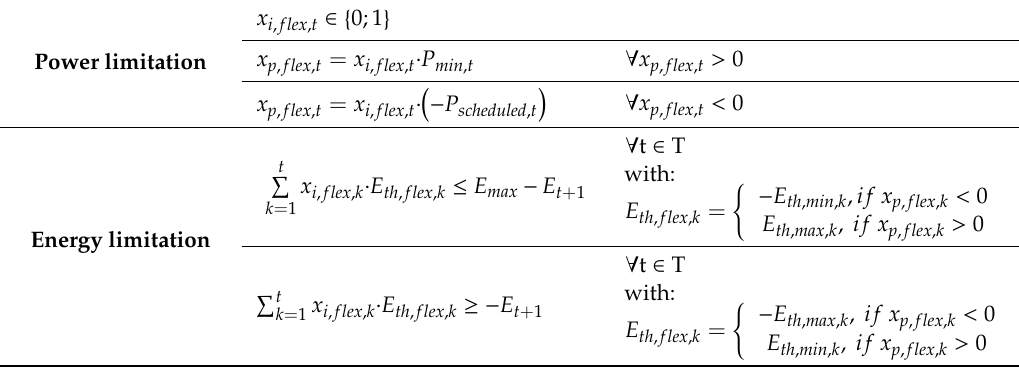
Table 2. Additional constraints added to the modified OPF calculation to constrain the use of flexibility to the available